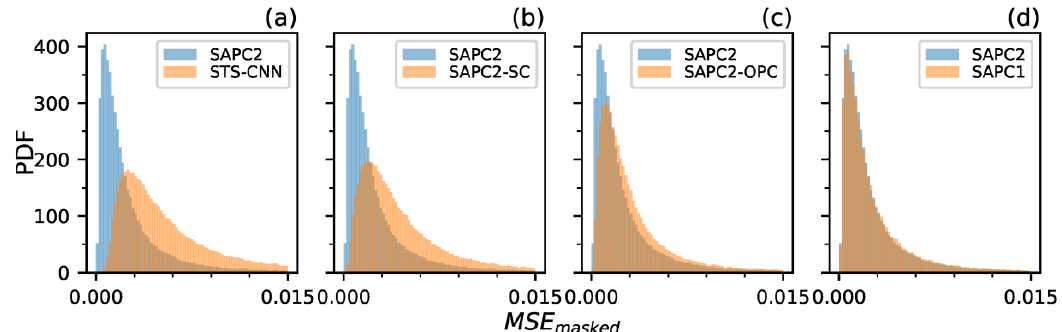
Figure 8. Comparison of Probability Density Functions (PDFs) of MSE masked between SAPC2 and STS-CNN ( a ), SAPC2-SC ( b ), SAPC2-OPC ( c ), and SAPC1 ( d ) on the entire validation dataset. Note that the bin size of the PDFs is small (i.e., 0.0002). As a result, the PDF values at some bins may be high, but the sum of the bin-size weighted PDF values in the full range of MSE masked still equals 1.